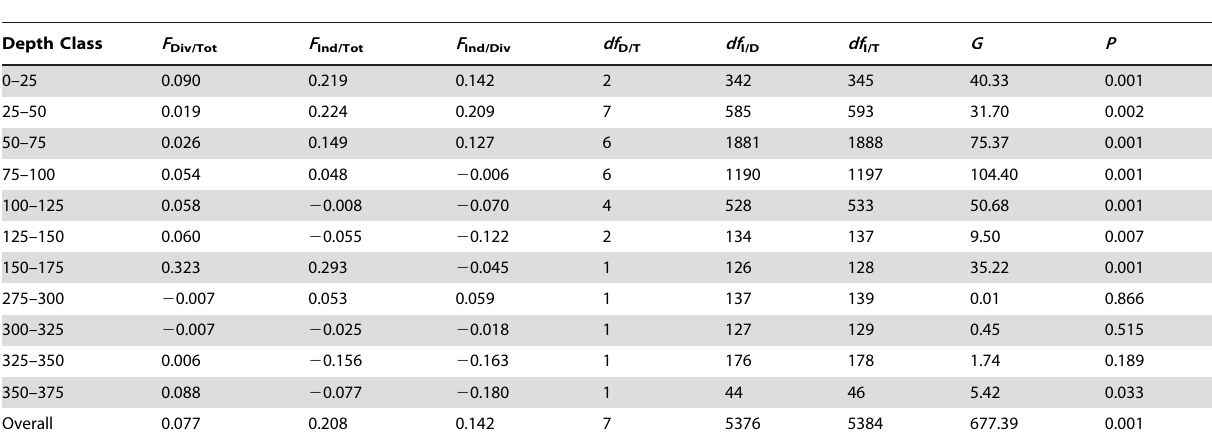
Table 4. F statistics among divisions within depth